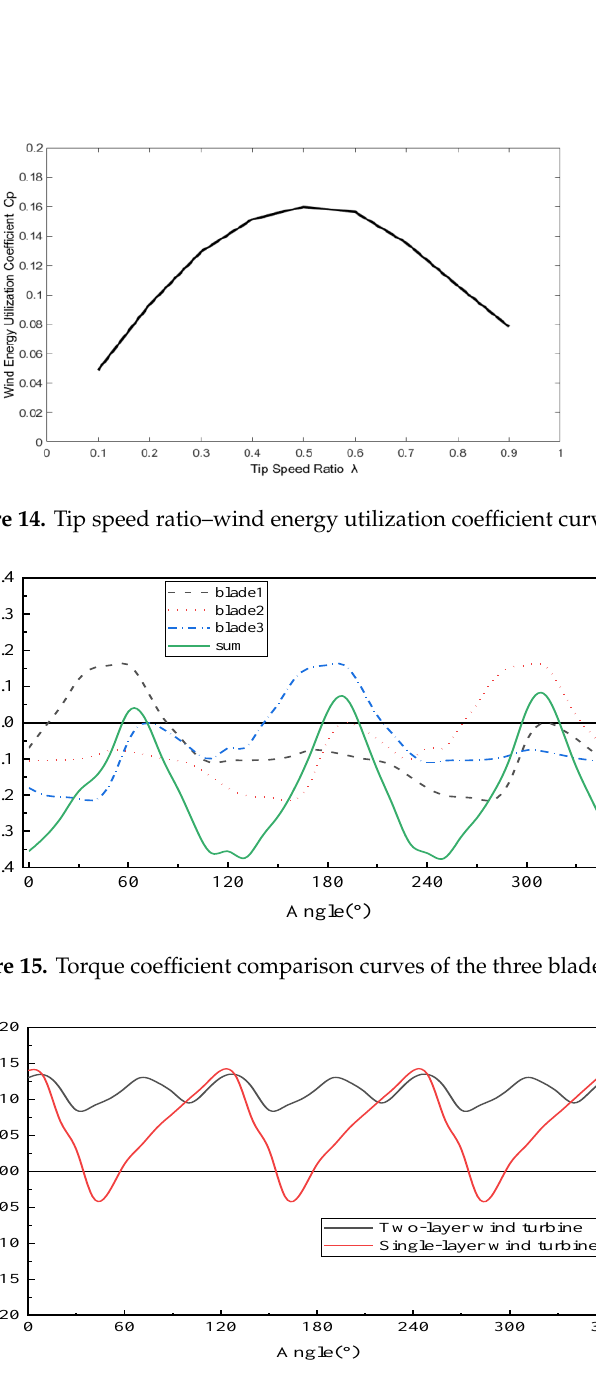
Figure 16. Torque coefficient comparison curves of single- and double-layer wind turbines.